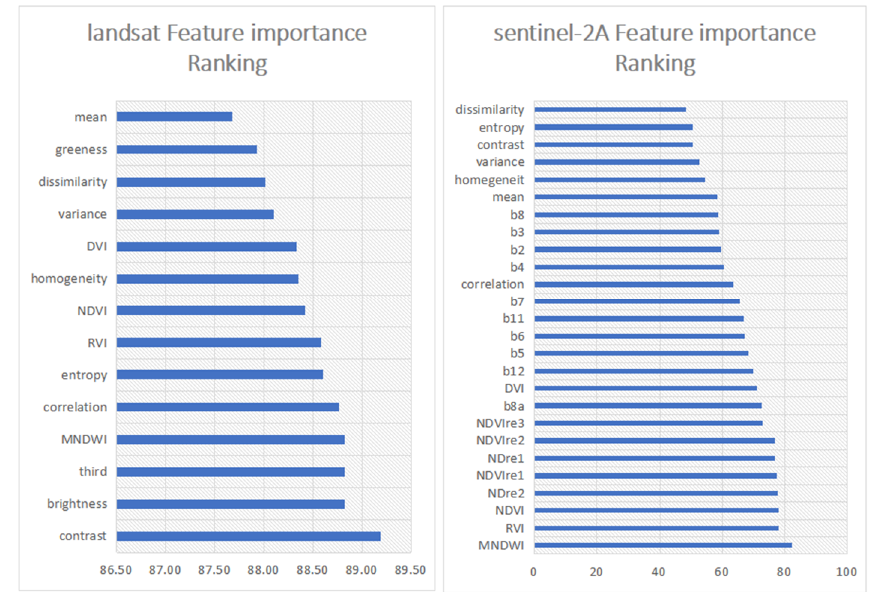
Figure 3. Feature-importance ranking.